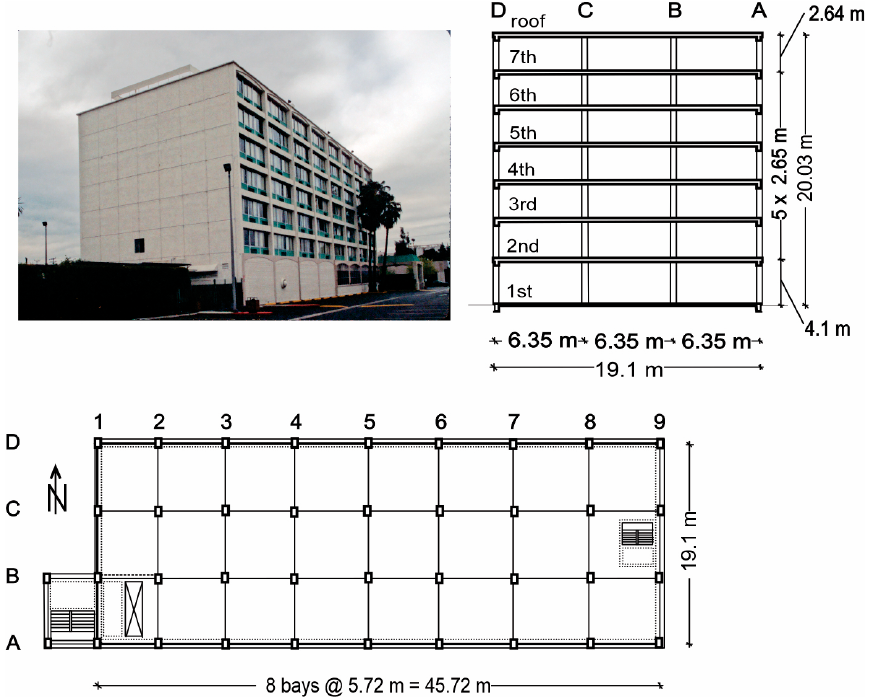
Figure 2. ( Top left ) View toward the southwest, ( top right ) typical transverse section, and ( bottom ) typical floor framing plan.